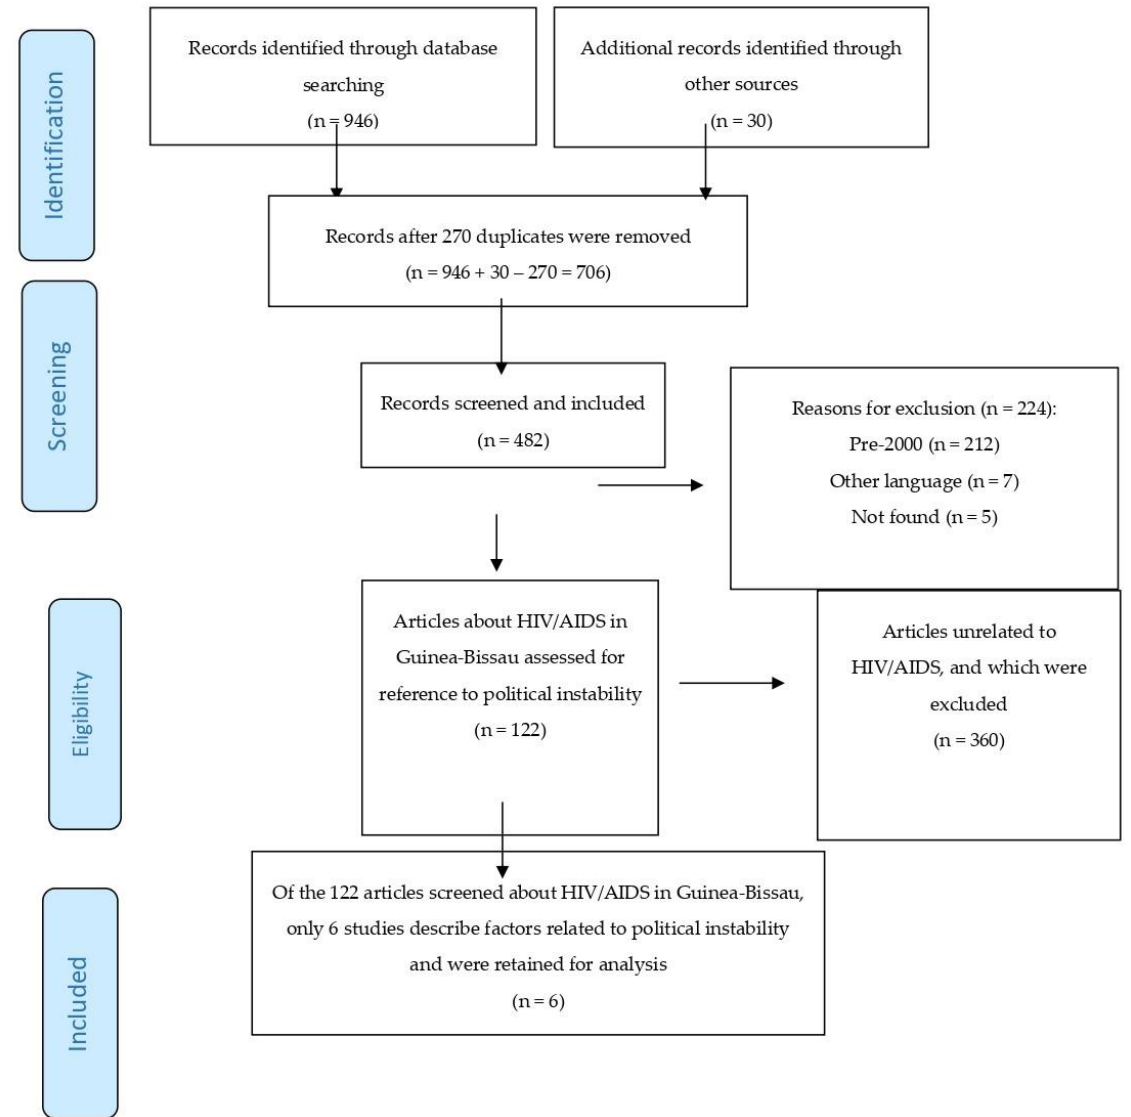
Figure 1. PRISMA flowchart.